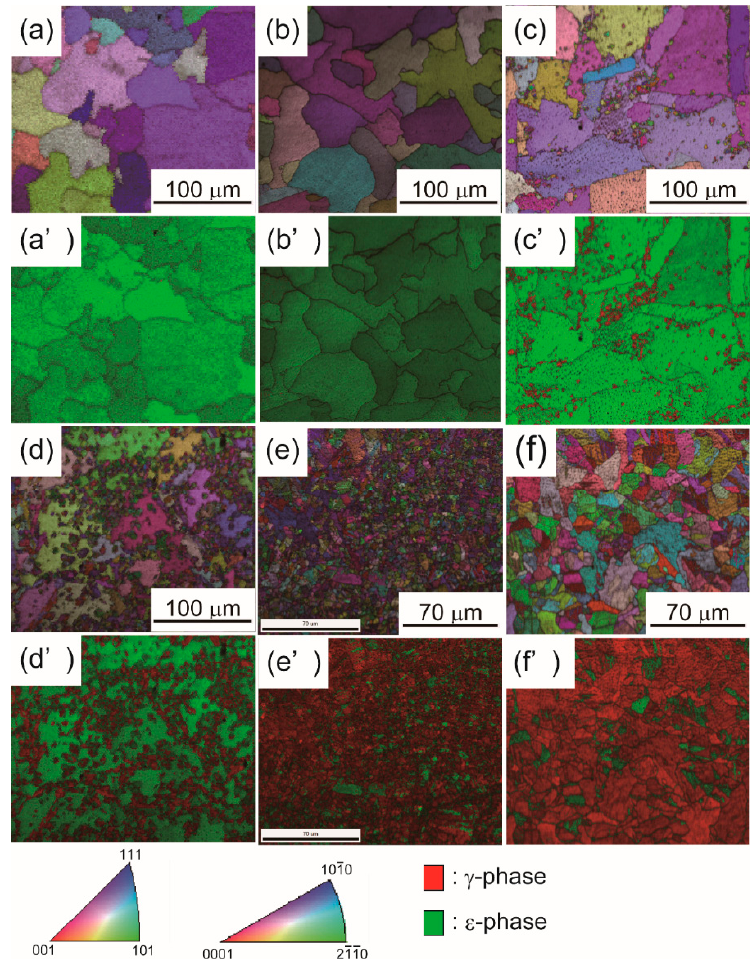
Figure 10. ( a – f ) electron backscattering diffraction inverse pole figure (EBSD IPF) and ( a ’– f ’) phase maps of the ( a , a ’) aged, ( b , b ’) middle RT 76, ( c , c ’) middle RT 78, ( d , d ’) middle RT 80, ( e , e ’) middle RT 90, and ( f , f ’) reversely transformed specimens of the low-C alloy.